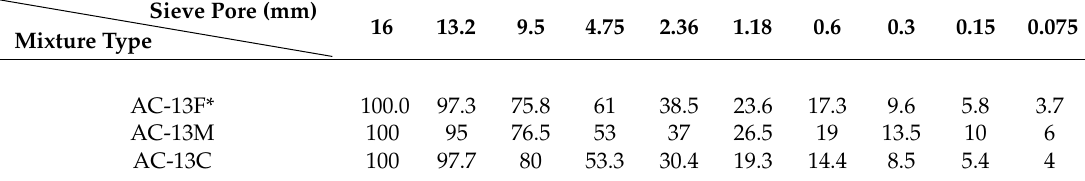
Table 1. The aggregate passing rate (%) from sieve pore for Asphalt Mixture. TypeSieve Pore (mm) Mixture